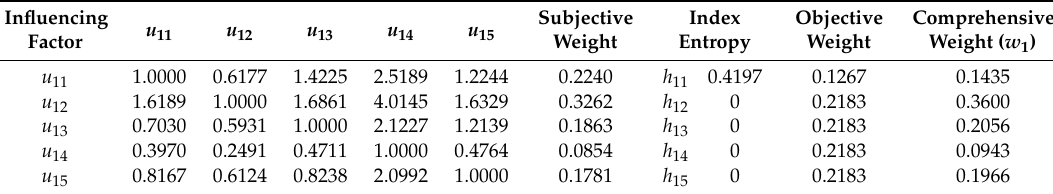
Table 15. The weights of the server influencing factors.